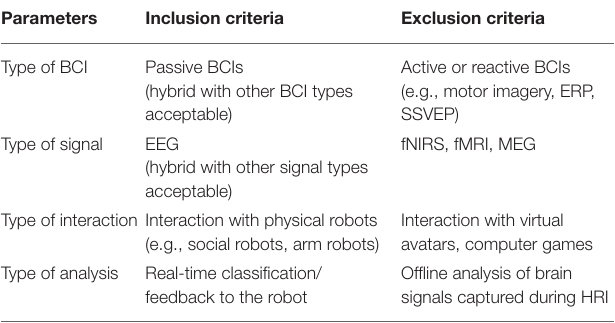
TABLE 1 | The inclusion and exclusion criteria as used for the selection of BCI-HRI studies in section BCIs and Human-Robot